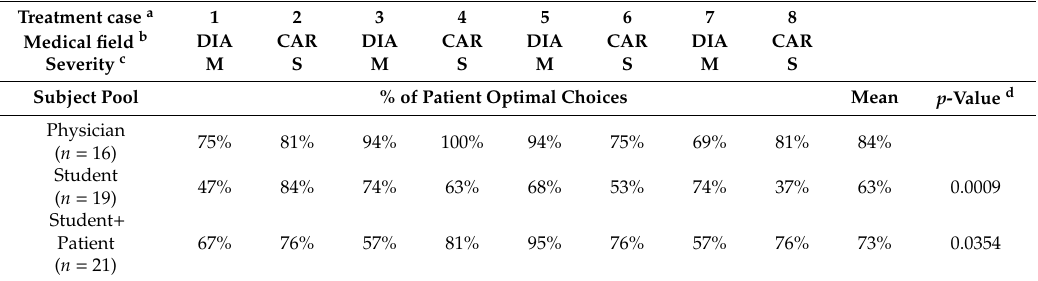
Table 4. Proportion of patient optimal choices by treatment case and subject pool in part 2 (performance